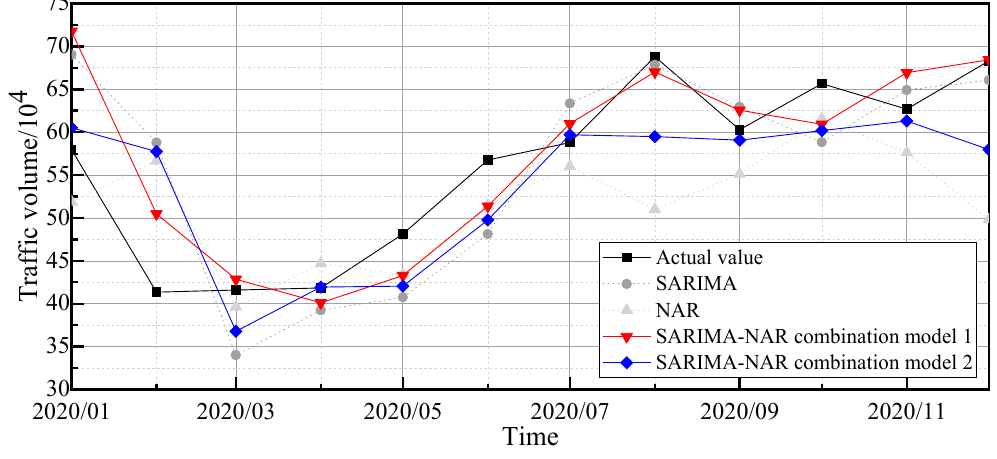
Figure 12. Forecast results of traffic volume under the influence of the epidemic.